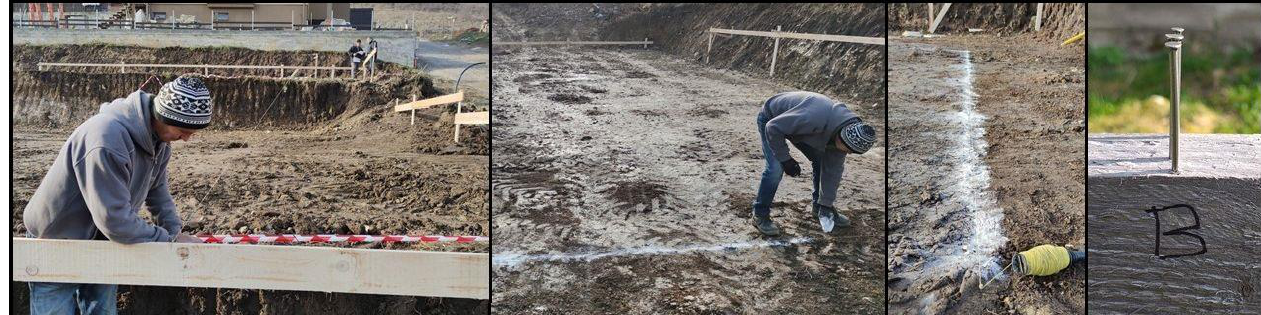
Figure 14. Construction twine and batter boards markings used for layout points positioning; obtained markings of the 4 methods of batter board stake-out ( right ).